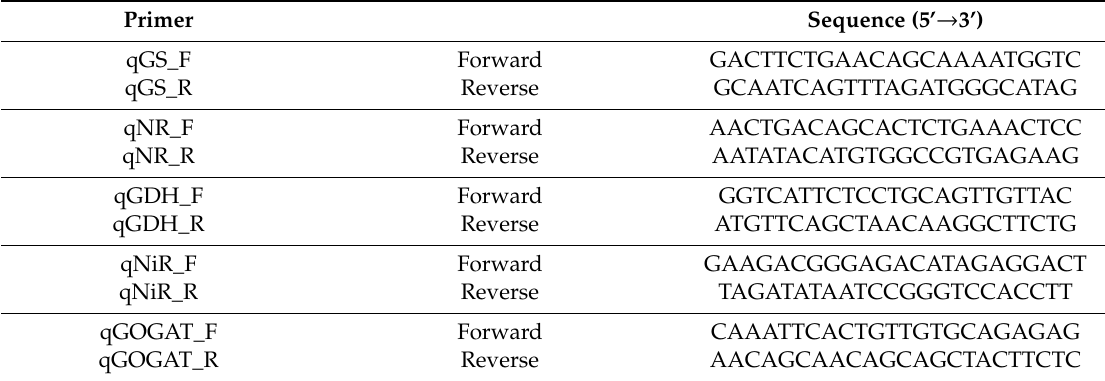
Table 1. Primers used in this